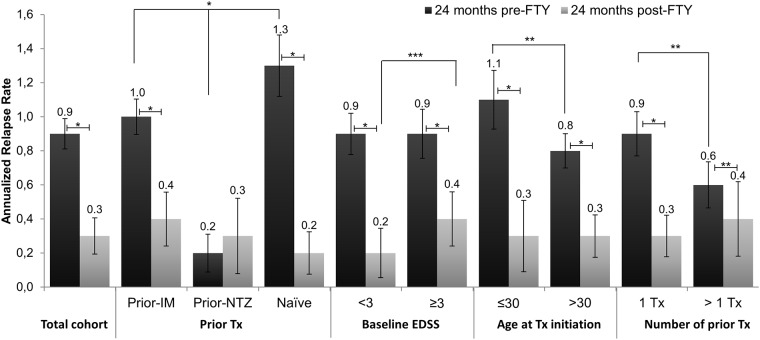
Annualized relapse rate in the 24 months prior to fingolimod treatment and the first 24 months of fingolimod for total cohort and stratified according to prior treatment, sex, age at the fingolimod treatment initiation and number of prior treatments.* p<0.0001; ** p<0.01; *** p<0.05. EDSS, Expanded Disability Status Scale, FTY, fingolimod, IM, immunomodulator; NTZ, natalizumab; Tx, treatment.